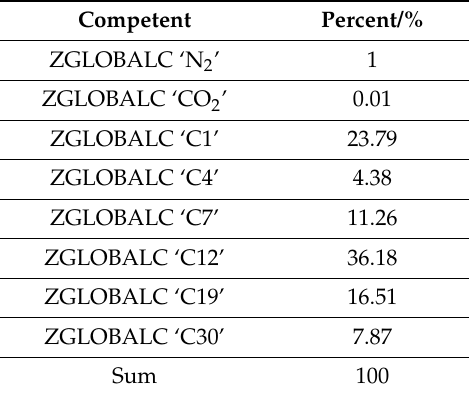
Table 5. Oil composition in the simulation model.